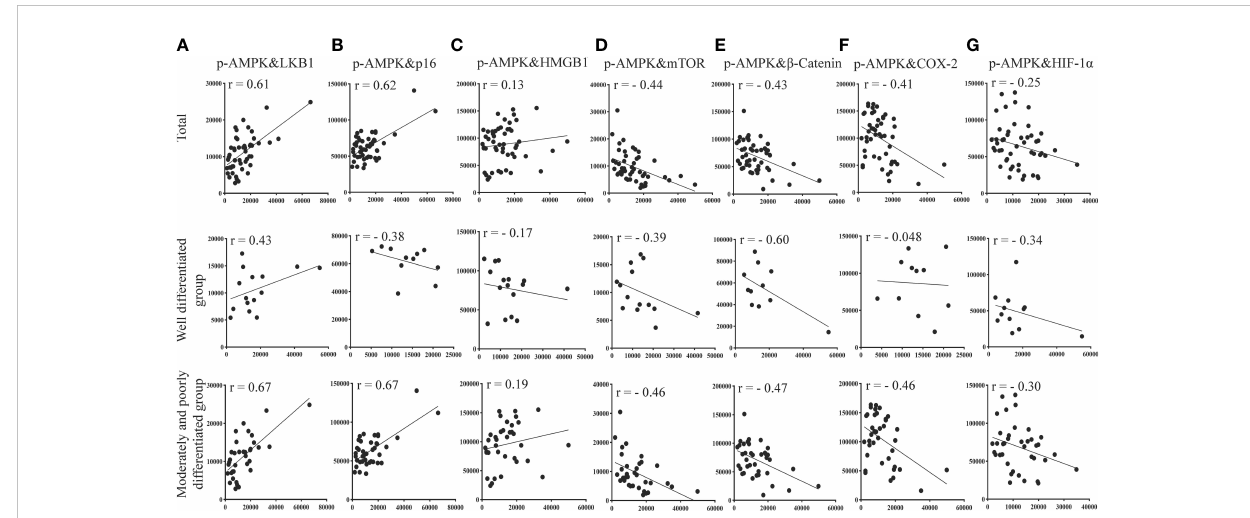
FIGURE 8 Correlation of p-AMPK with LKB1, mTOR, in fl ammatory factors (COX-2, b -catenin, HMGB1), aging factor (p16), and hypoxia factor (HIF-1 a ) proteins expressed at the same site in the same region of tumor tissue from patients with liver cancer. (A) Correlation between p-AMPK and LKB1 expression in the same region. (B) Correlation for p-AMPK and p16 expression in the same region. (C) Correlation of p-AMPK and HMGB1 expression in the same region. (D) Correlation of p-AMPK and mTOR expression in the same region. (E) Correlation of p-AMPK and b -catenin expression in the same region. (F) Correlation of p-AMPK and COX-2 expression in the same region. (G) Correlation of p-AMPK and HIF-1 a expression in the same region. When r > 0, the two variables are positively correlated. When r < 0, the two variables are negatively correlated. When |r| ≥ 0.8, the two variables can be considered highly correlated. When 0.8 > |r| ≥ 0.5, the two variables can be considered moderately correlated. When 0.5 > |r| ≥ 0.3, the two variables can be considered slightly correlated, and |r| < 0.3 means the correlation is weak and